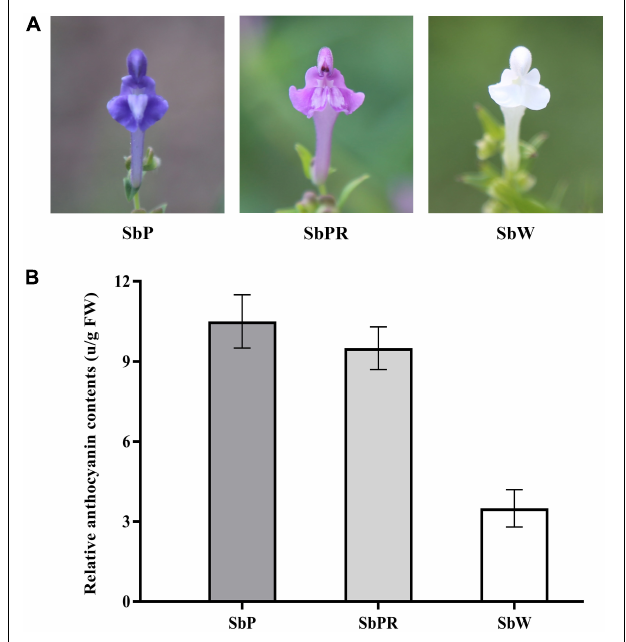
FIGURE 1 | Scutellaria baicalensis Georgi. flowers used in this study. (A) Phenotypes of S . baicalensis flowers. (B) Measurement of relative anthocyanin contents in flowers of SbW, SbPR, and SbP. SbW, white flower at the blooming stage; SbPR, purple-red flower at the blooming stage; SbP, purple flower at the blooming